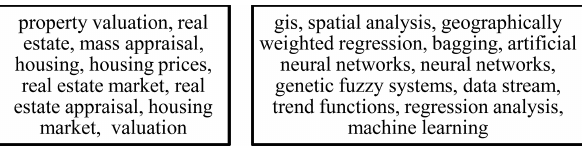
Figure 2. Methodological and technical